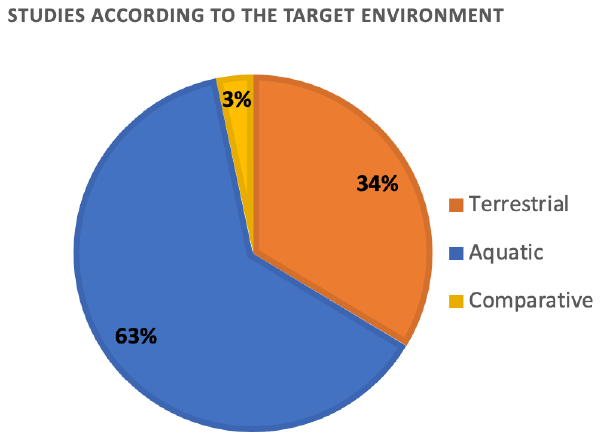
Figure 3. Percentage of selected studies categorized according to the terrestrial or aquatic environ- ment. Comparative studies targeting both terrestrial and aquatic environments are also reported.